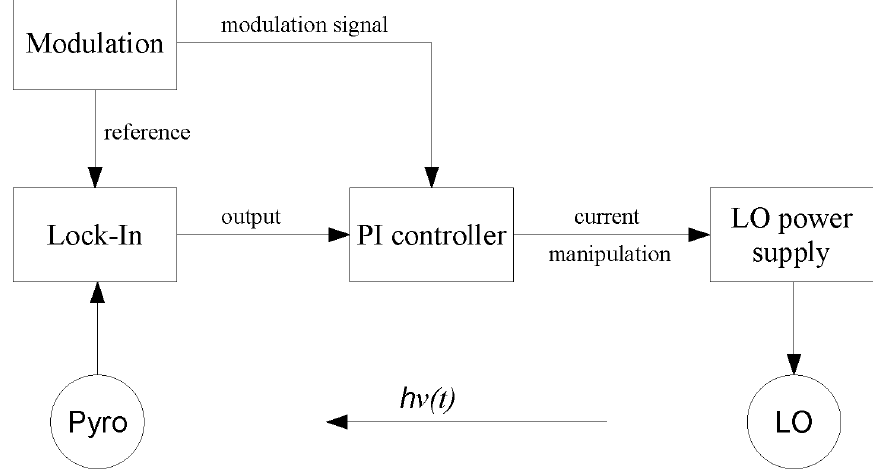
Figure 2. Schematic view of the frequency stabilization circuit. The LO output beam is reflected to the beam splitter and then fed through a gas cell. The signal is detected and converted (pyro), analyzed and compared to the applied modulation (lock-in) and counteracted (proportional-integral (PI)) to keep the LO frequency stable by the current